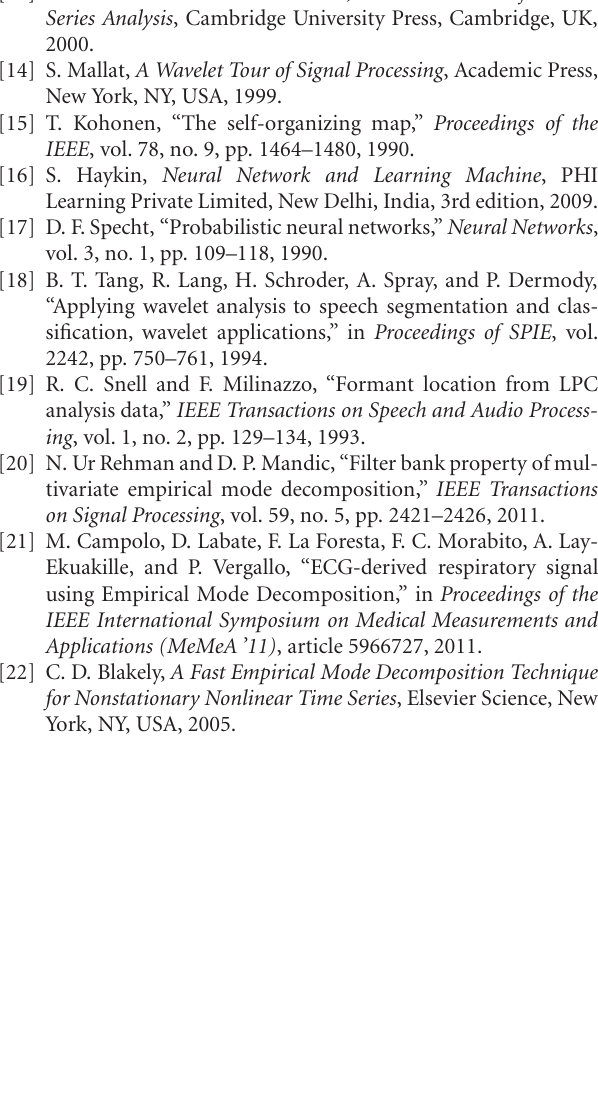
Table 4: DWT versus SOM segmentation success